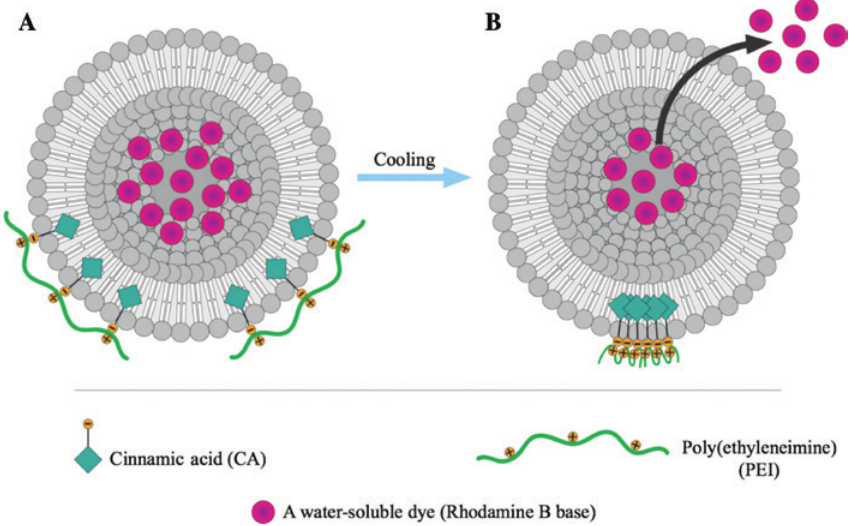
Figure 1: Schematic of temperature-dependent behavior of liposome-conjugating PEI-CA (A) above UCST and (B) below